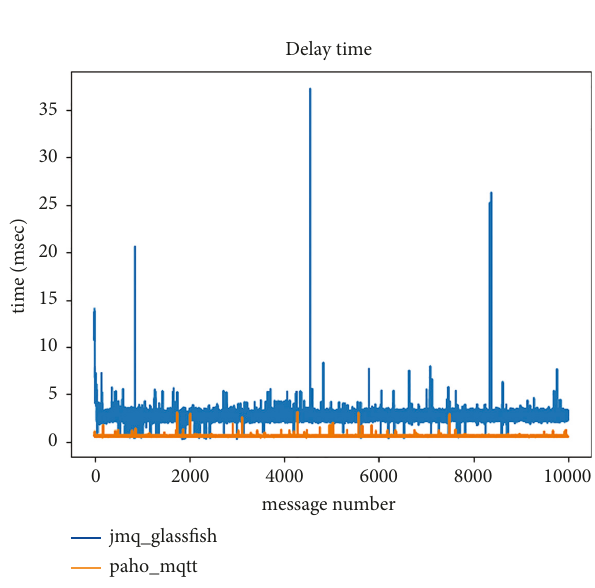
Figure 10: FastRTPS’s and RabbitMQ’s delay of minimum mes- sage size.